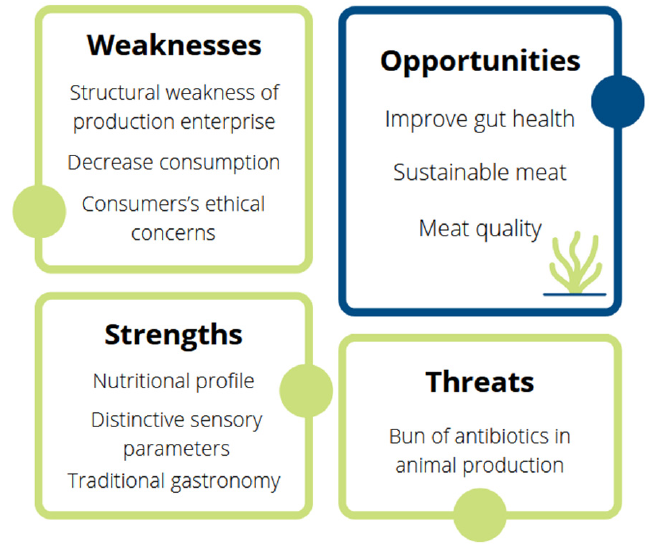
Figure 1. SWOT analysis of rabbit farming.